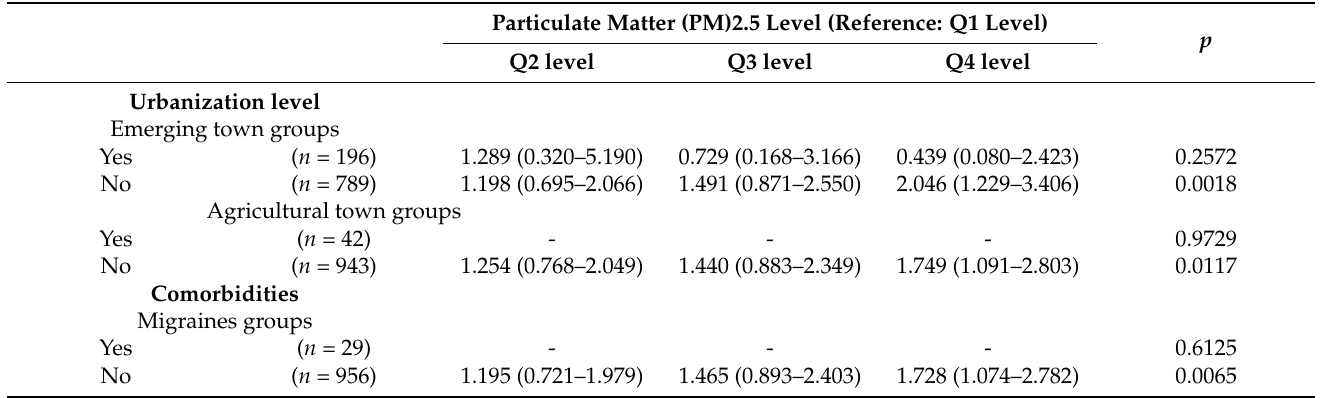
Table 3 Subgroups logic regression analysis of Particulate matter (PM)2.5 level and Glaucoma. Adjustment for gender, age, low-income, urbanization level, comorbidities. OR, odds ratio; CI, confidence interval. Particulate Matter (PM)2.5 Level (Reference: Q1